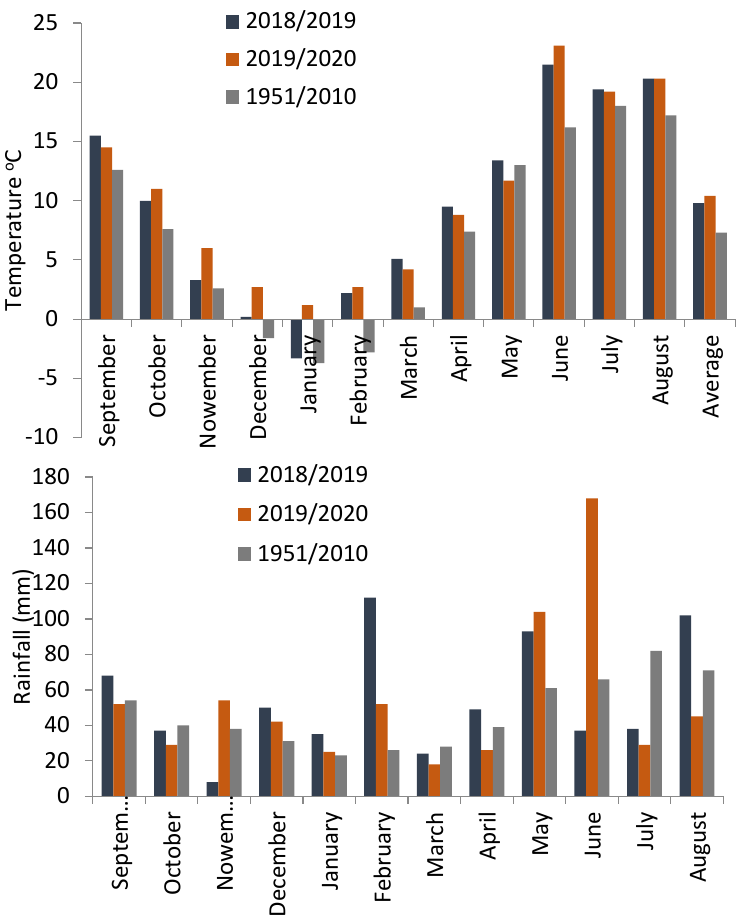
Figure 1. Average air temperatures and total rainfall during the experimental trials (2018–2019). Data were obtained from the Meteorological Station in Felin, 51, 13°N; 22, 37°E.